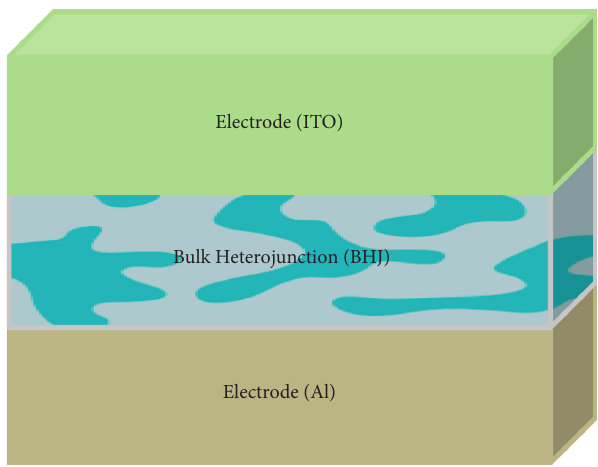
Figure 1: The basic device structure of polymer solar cells.